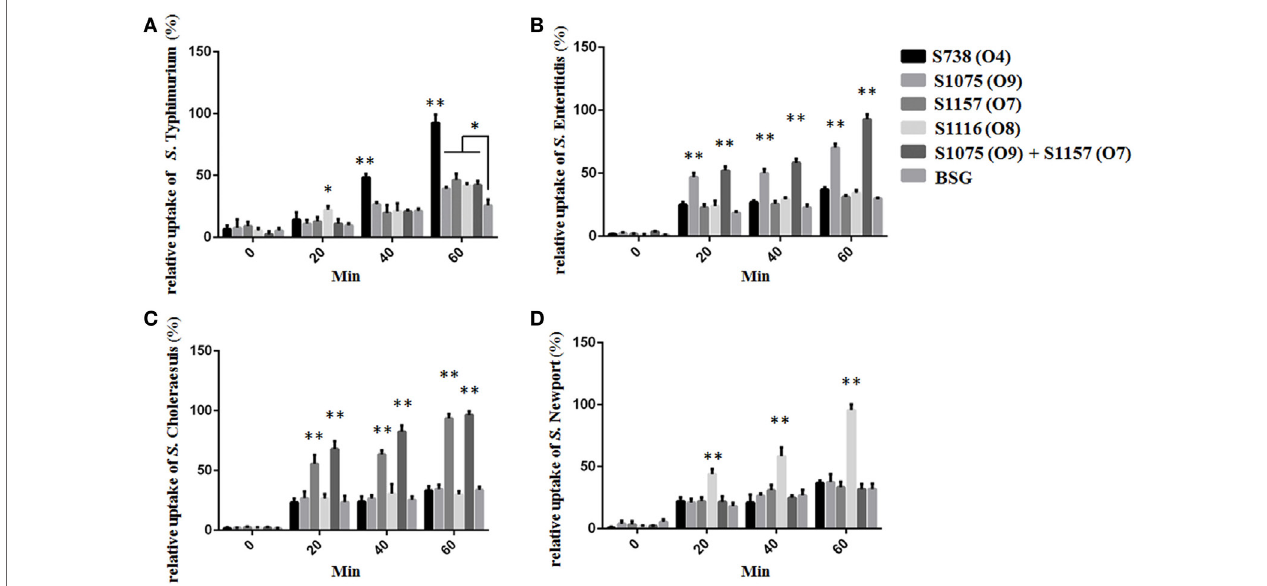
FigUre 5 | The differential uptake of Salmonella by RAW264.7 cells after serum opsonization. Compared to cells from control groups ( Salmonella opsonized with naive serum), the uptake of S. Typhimurium (a) , S. Enteritidis (B) , S. Choleraesuis (c) , and S. Newport (D) opsonized with sera from mice primed with S738 (O4), S1075 (O9), S1157 (O7), and S1116 (O8), respectively, was significantly higher (**, P < 0.01). The number of enumerated cells was normalized to 100% for the maximal value. Error bars represent SEs of the